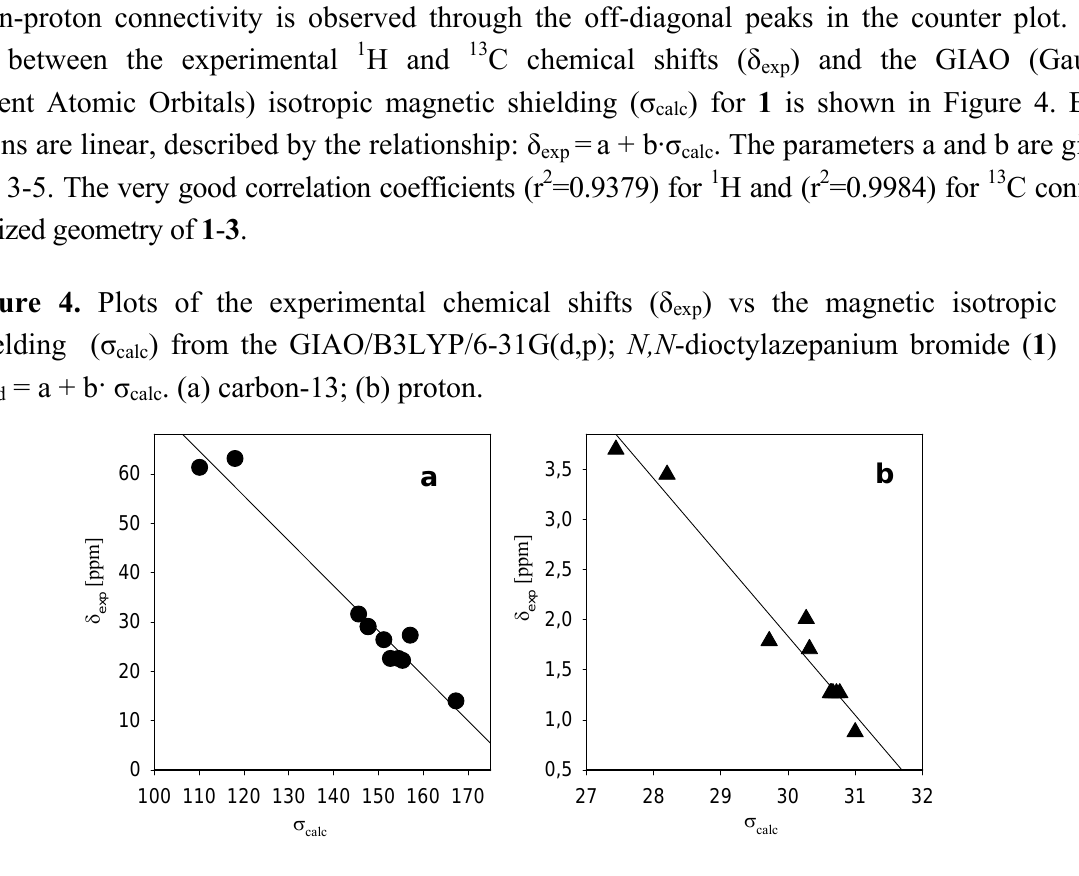
and calculated GIAO nuclear magnetic 3 = a + b· σ with a and b determined from the exp calc